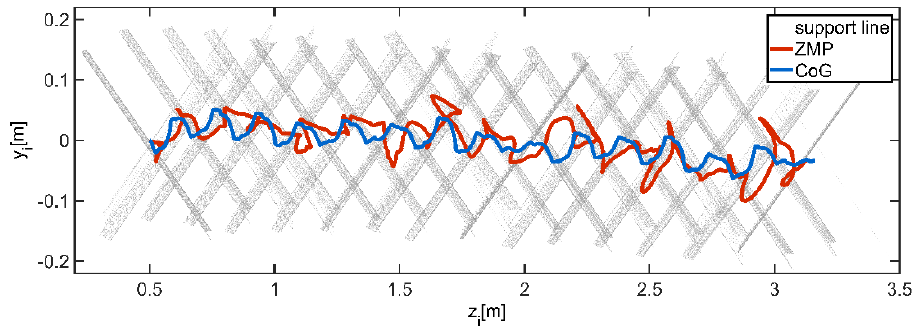
Figure 14. Positions of the support line and ZMP .